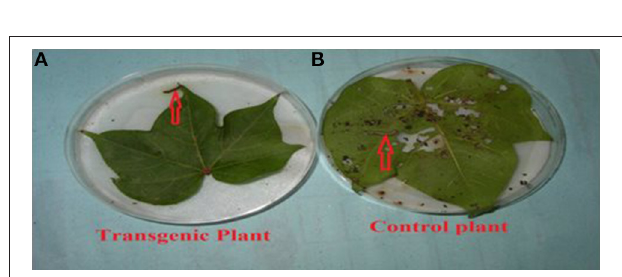
FIGURE 9 | Insect bioassay of leaves of transgenic and control cotton plant. (A) Transgenic plant leaf showing killed larvae after eating a small portion of leaf and plate. (B) Control non-transgenic plant. Larva remained active and alive after damage.